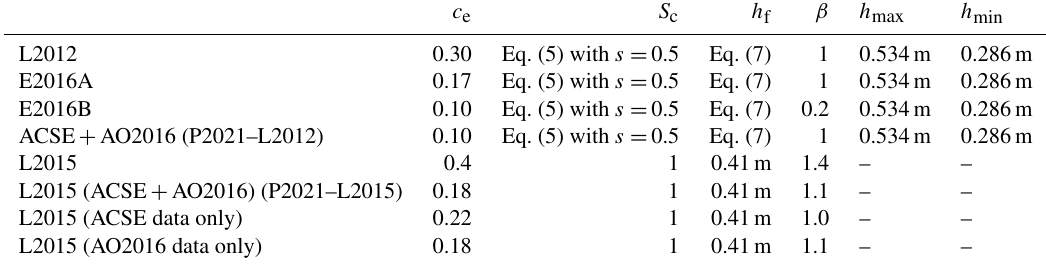
Table 1. Parameter settings for the form drag component of the L2012 scheme (Lüpkes et al., 2012, rows 1–4): as recommended in L2012, E2016A and E2016B, P2021–L2012; and the L2015 scheme (Lüpkes and Gryanik, 2015, rows 5–8): as recommended in L2015, and fit to ACSE + AO2016, ACSE only, AO2016 only. The L2012 variants use: D min = 8m and D max = 300m, whereas the L2015 variants use D min = 300m. The primary tuning parameter is the effective resistance coefficient, c e , whereas β has a second-order effect on the shape of the curve. S c and h f were tunable parameters in L2012, but found by L2015 to have a marginal impact and set as constants for simplicity. P2021–L2015 is the proposed parameterization which is presented with L2015 anchored at the observed values of C D10nw and C D10ni . c